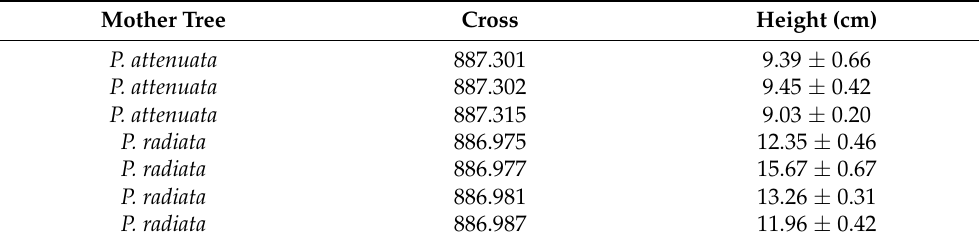
Table 6. Height of somatic plants (cm) from embryogenic cell lines in which P. attenuata or P. radiata var. cedrosensis acted as the mother and from different initiation treatments (1, 2 and 3) after six months in the